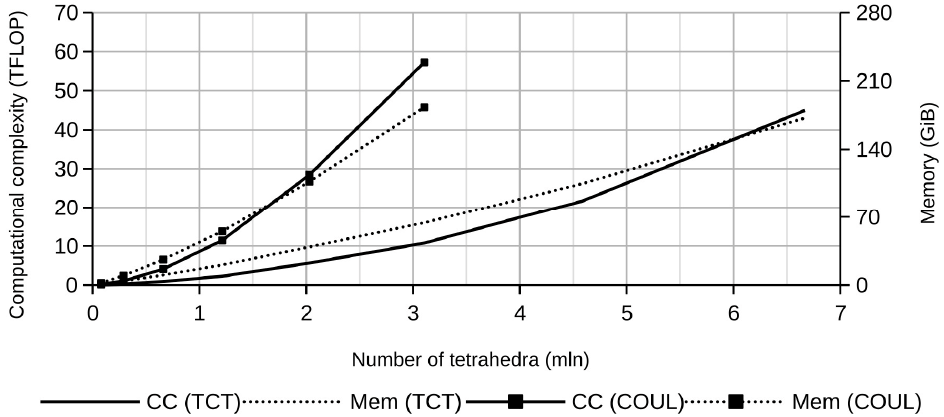
Figure 3. Dependence of computational complexity (“CC”) and the necessary amount of memory (“Mem”) on the number of elements in the mesh for two variants of the vector magnetic potential gauging (“TCT”—tree–cotree, “COUL”—Coulomb).